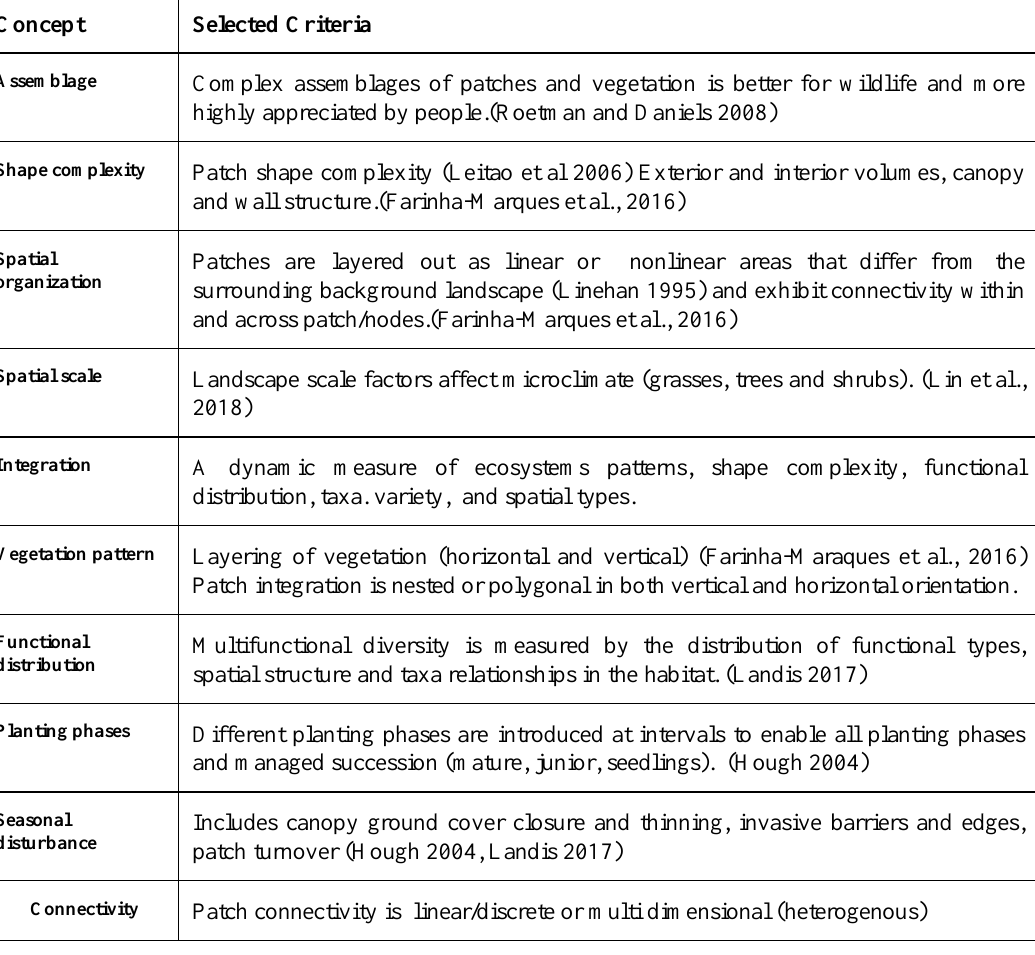
Table 1.Concepts supporting heterogeneity in constructed